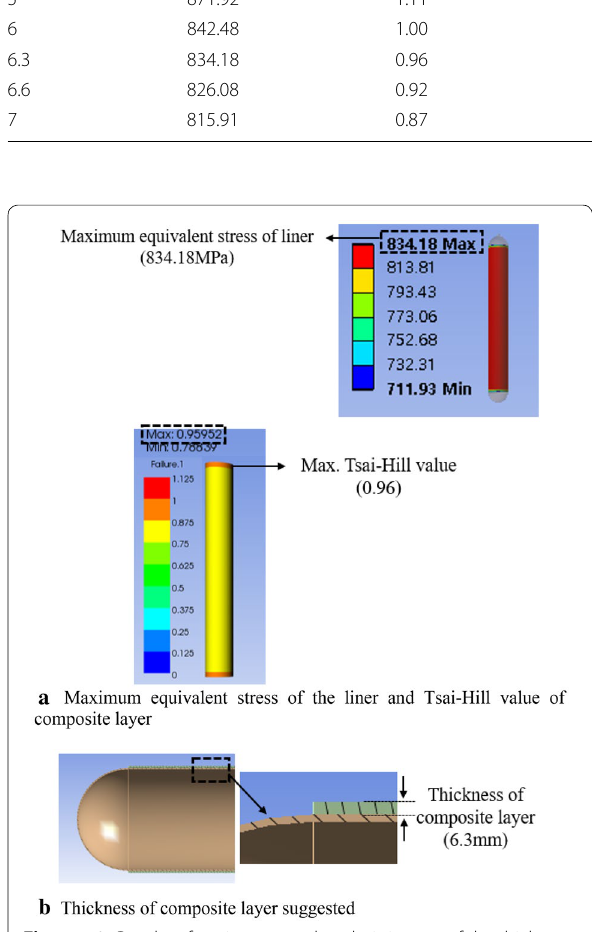
Figure 19 Results of static structural analysis in case of the thickness of composite layer (6.3 mm)